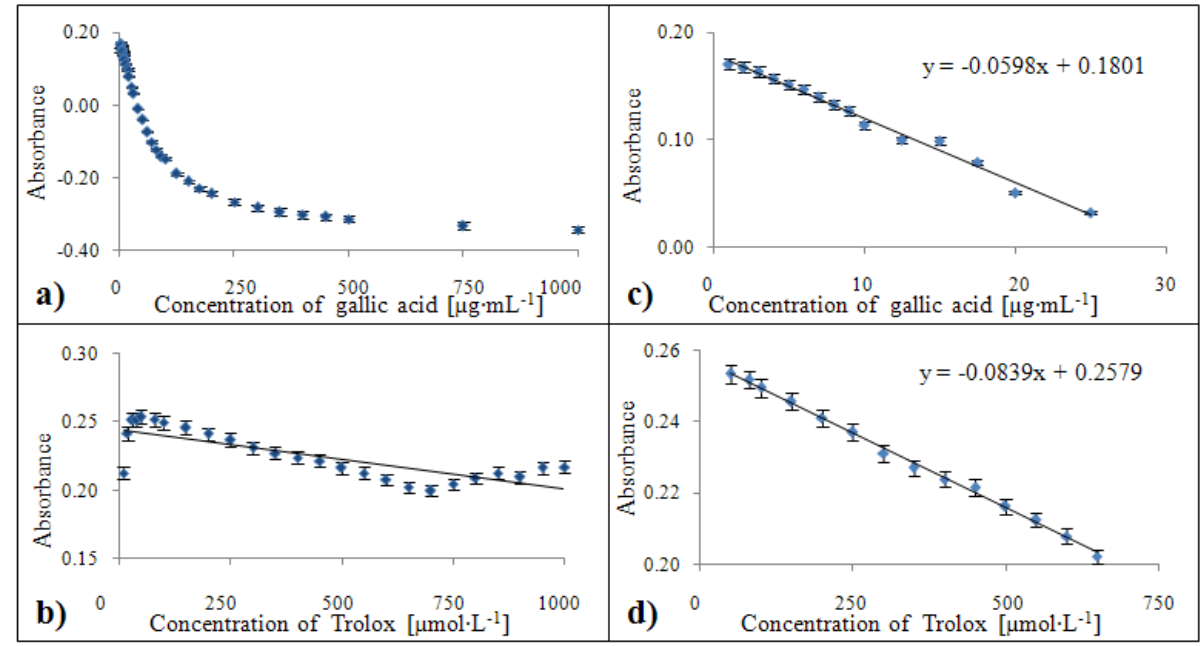
Figure 10. Dependences of absorbance of colour product on concentration of gallic acid ( a ) and Trolox ® ( b ). Calibration curves for DMPD method related to equivalent of gallic acid ( c ) and Trolox ® ( d ) expressed in units of